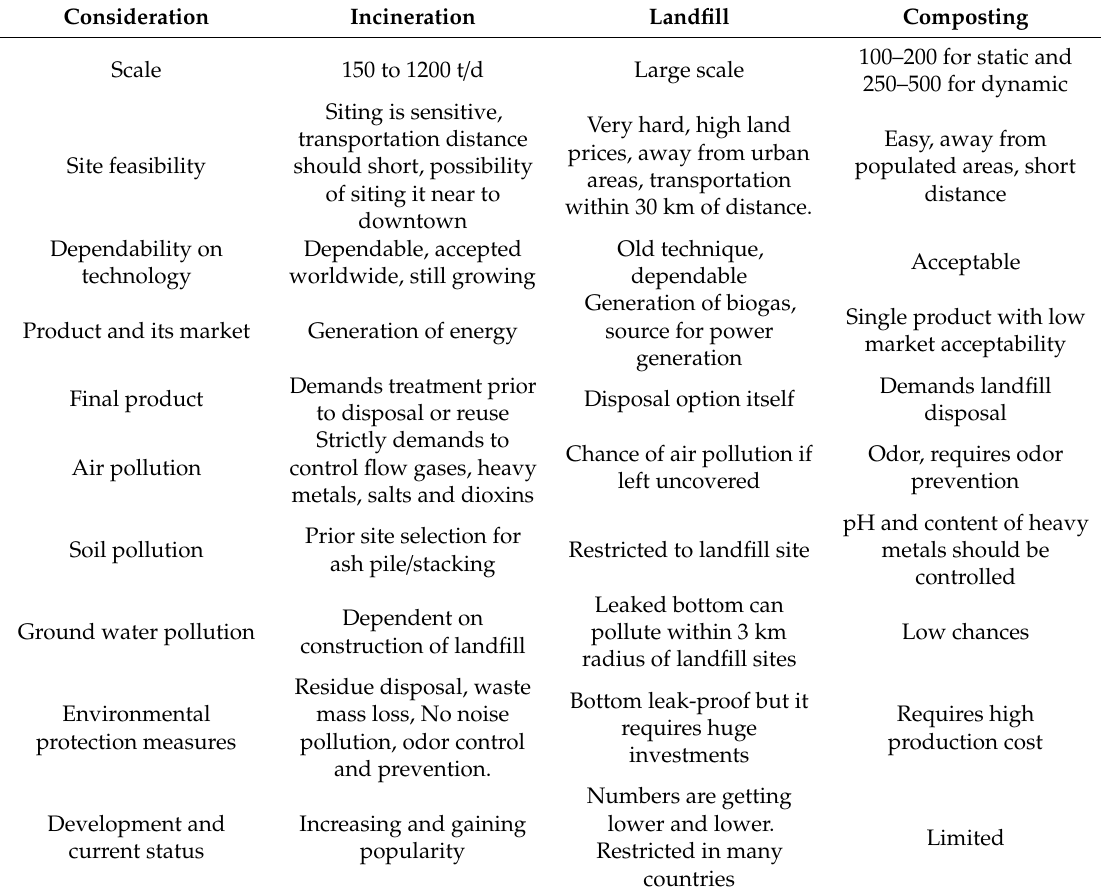
Table 2. Comparison of waste disposal